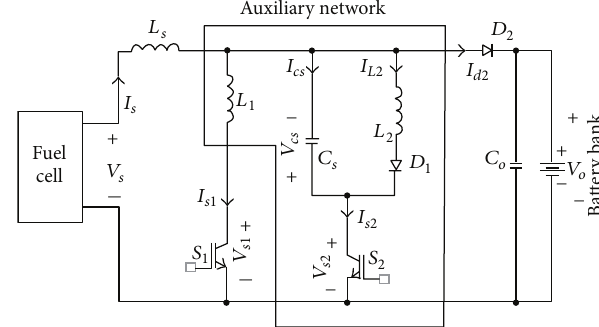
Figure 8: New soft-switched DC-DC boost converter, Saha